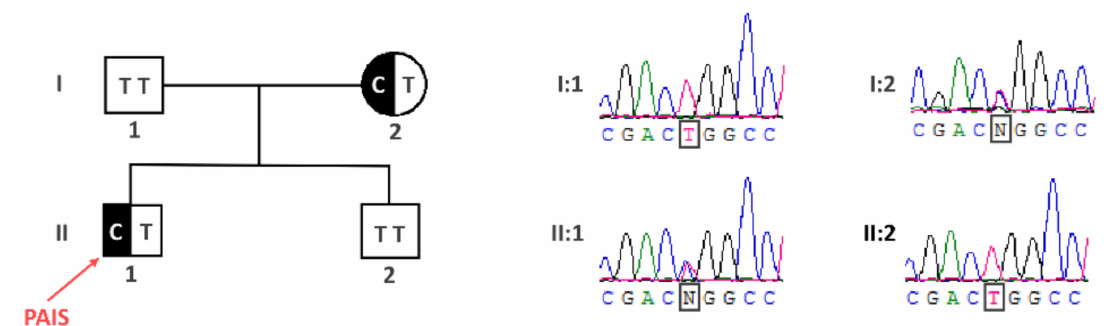
Figure 1. The identification of the FKBP4:c.956T > C (p.Leu319Pro) mutation in the partial androgen insensitivity syndrome (PAIS) patient. The pedigree shows the inheritance of the FKBP4 mutation according to an autosomal dominant model, with the phenotype restricted to male